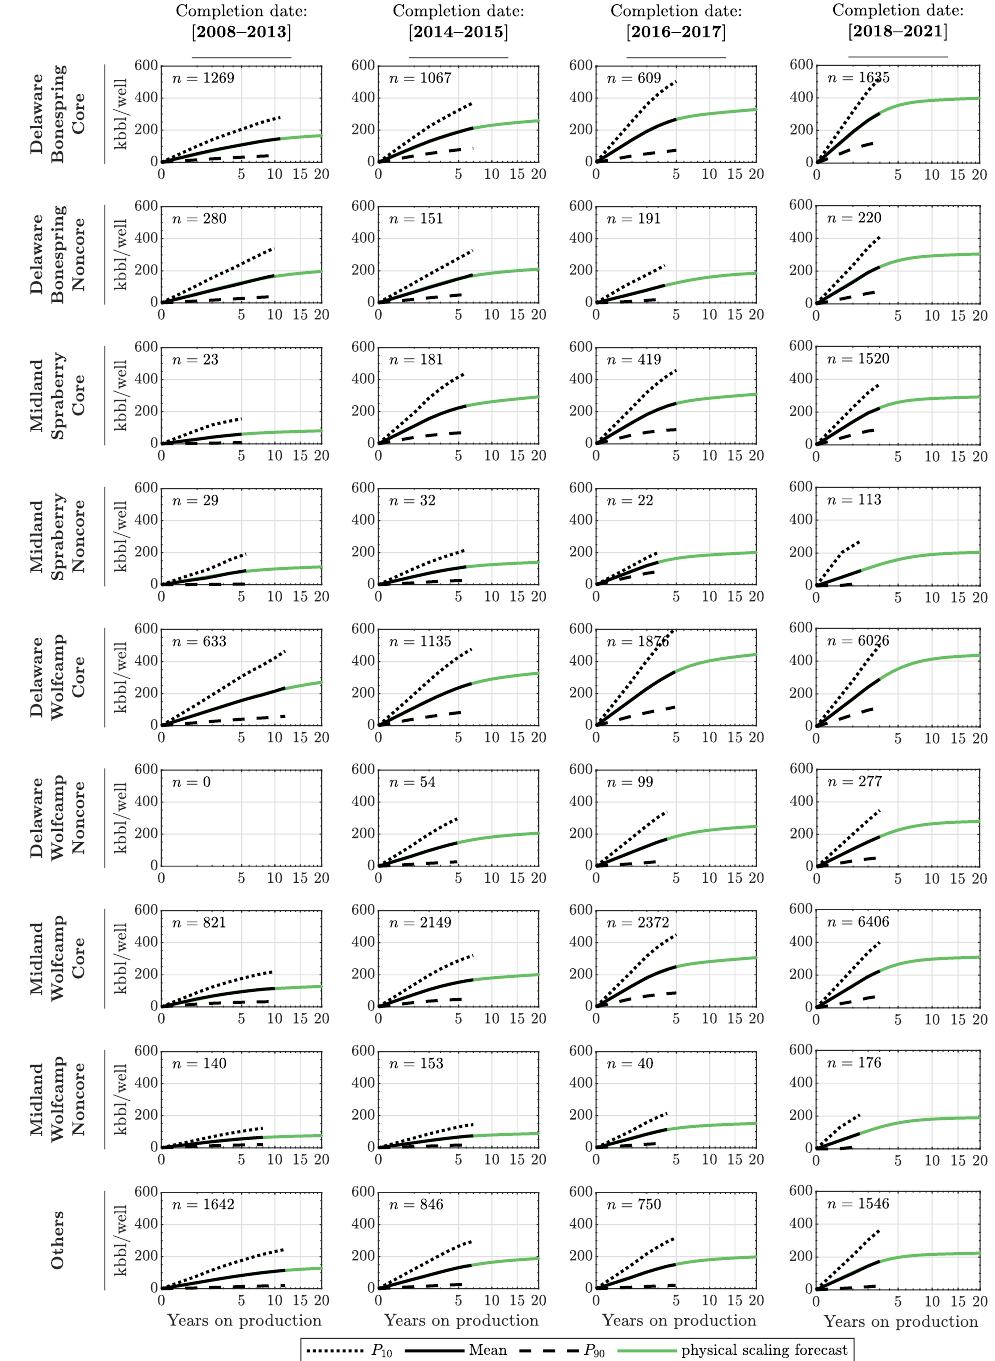
Figure 6. The black lines show the historical mean, upper bound ( P 10 ), and lower bound ( P 90 ) from the GEV statistics of the 36 well cohorts in the Permian Basin. The green lines are the extended well prototypes from physical scaling that predict smoothly the future oil production for up to two more